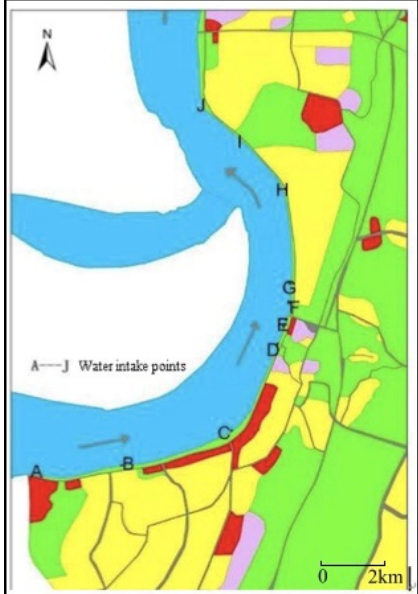
Figure 4. Water sampling sites at the south bank of Yangtze River in Chongqing.